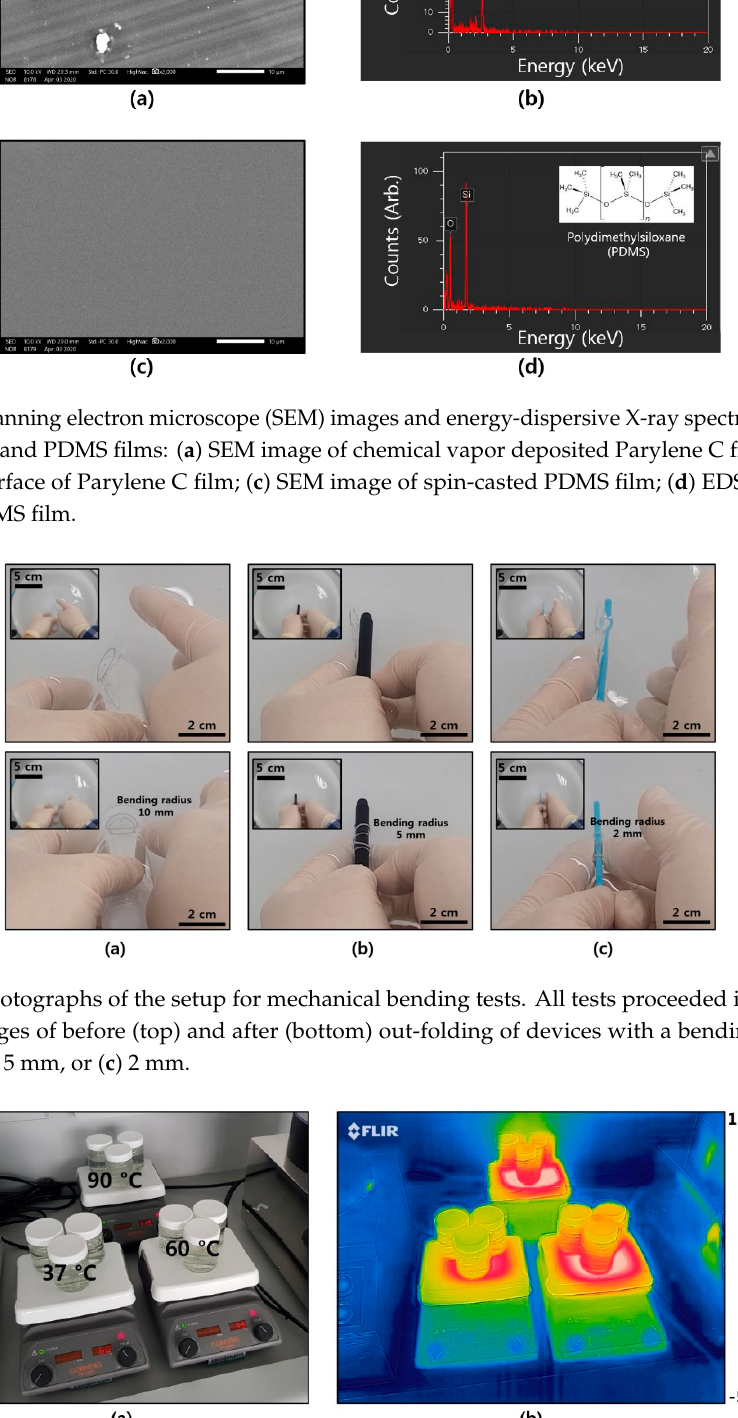
Figure A6. Setup for acceleration tests. ( a ) Photograph of the bottles containing various devices on